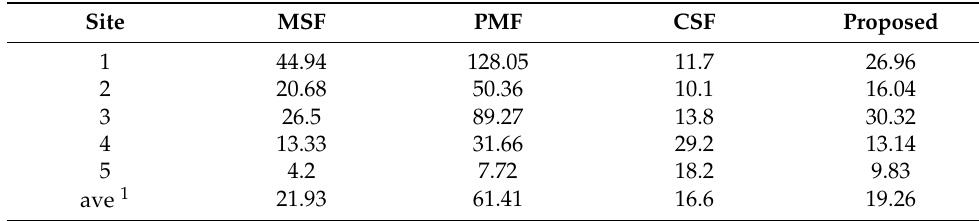
Table 5. Runtime of four filtering methods in five forested sites (s). Site